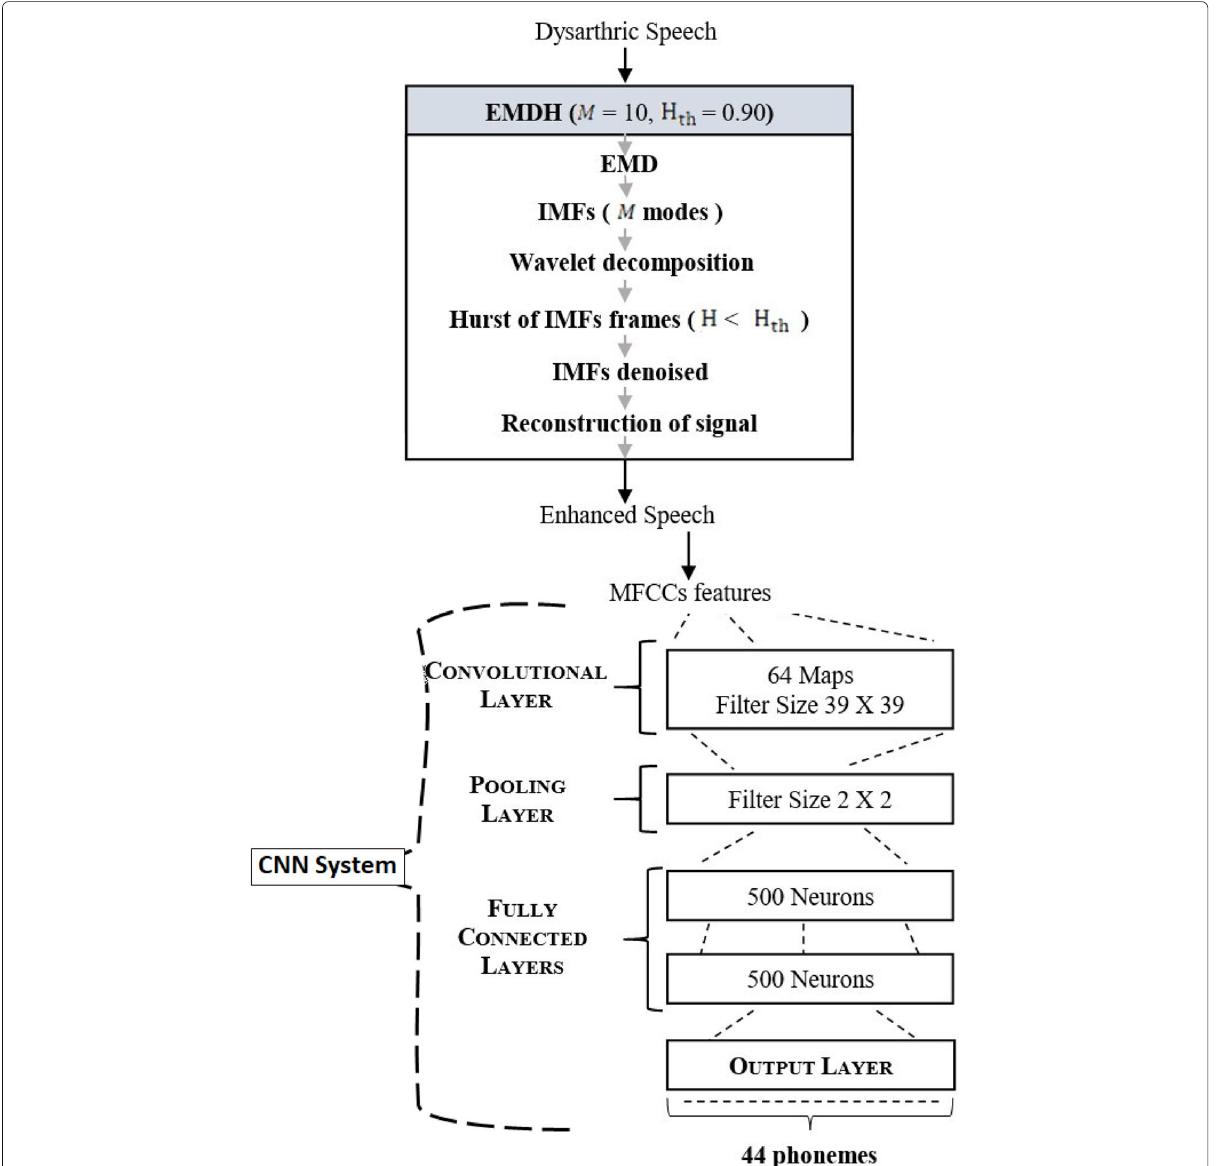
Fig. 2 EMDH-CNN system